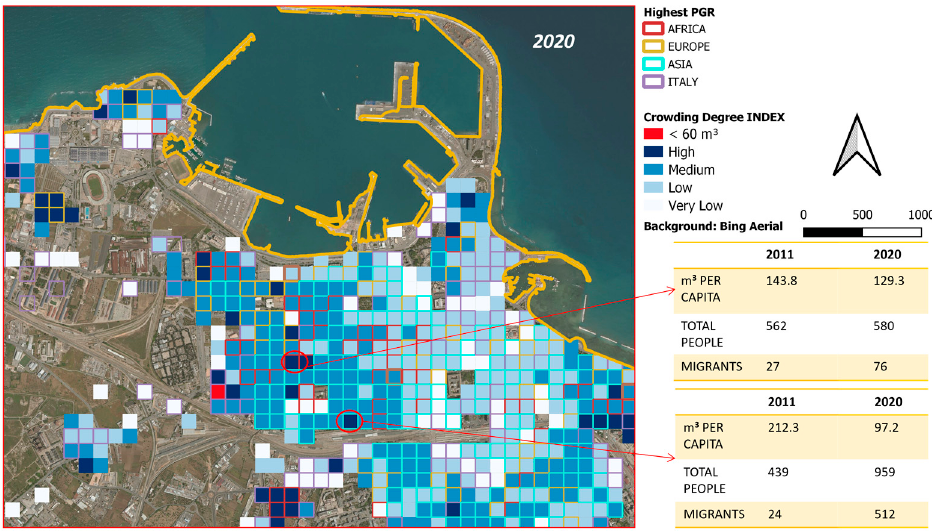
Figure 22. Close-up of Bari central area: increasing crowding degree in some cells with highest migrant PGR.